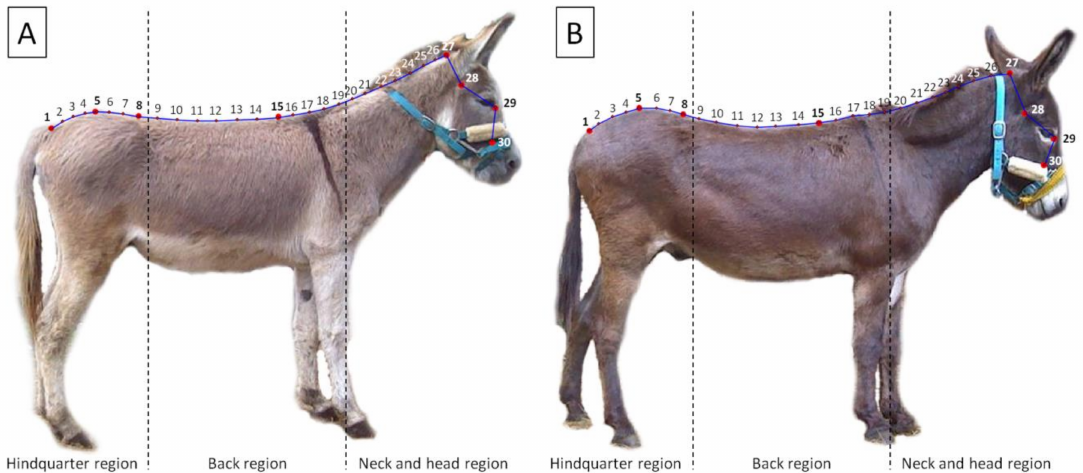
Figure 2. An example of the landmarks (marked with a big red point and bold font) and the sliding semilandmarks (marked with a small red point) digitalization on photography of donkeys classified following the fatty neck score (FNS): ( A ) FNS 0, and ( B ) FNS 5. The blue curves were fitted to the shape of the dorsal profile of animals. In post-processing, the TPS curves were appended to 30 landmarks. Consecutive landmarks are marked with increasing numbers from the first caudalis vertebra (1) to the tuber faciale (30). Dashed lines indicate the boundaries between